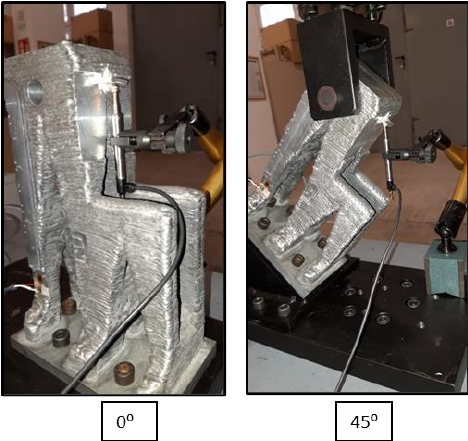
Figure 12. Positioning of the LVDT sensor in the test for WAAM AA5356 oriented at 0° and 45°.